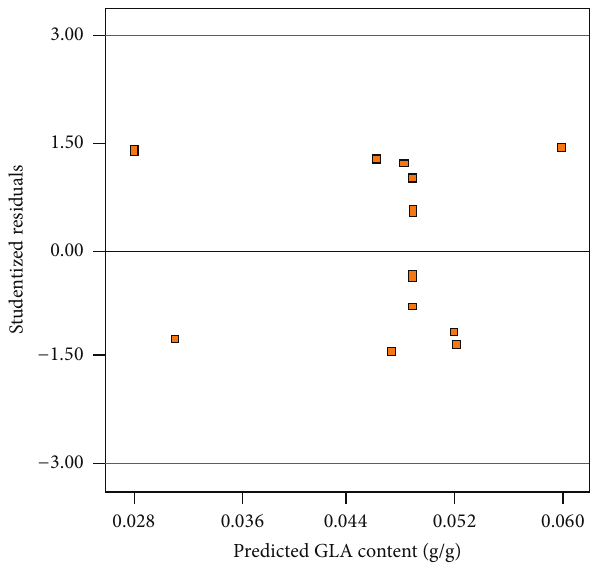
Figure 12: Plot of studentized residuals versus the predicted GLA